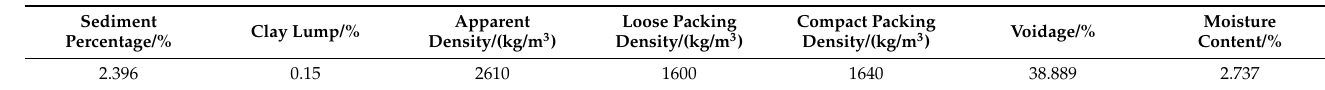
Table 4. Performance index of sand.